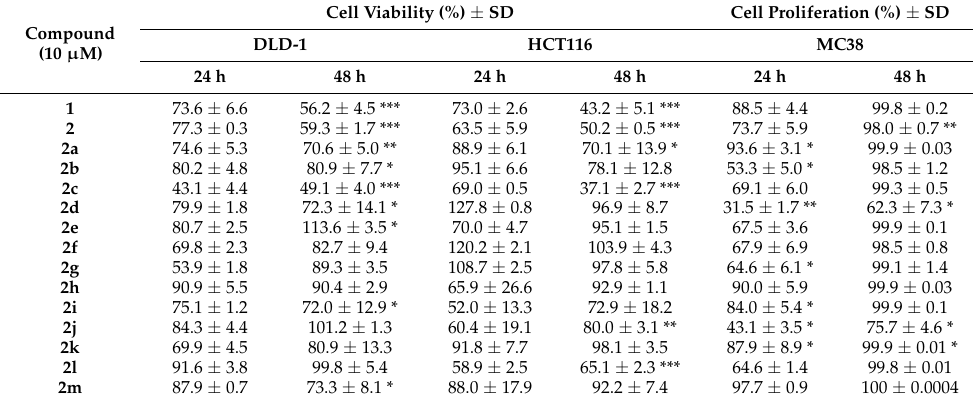
Table 1. Distribution of cell viability and proliferation percentages at different time points and at 10 µ M concentration in human (HCT116, DLD-1) and murine (MC38) colorectal adenocarcinoma cell lines.